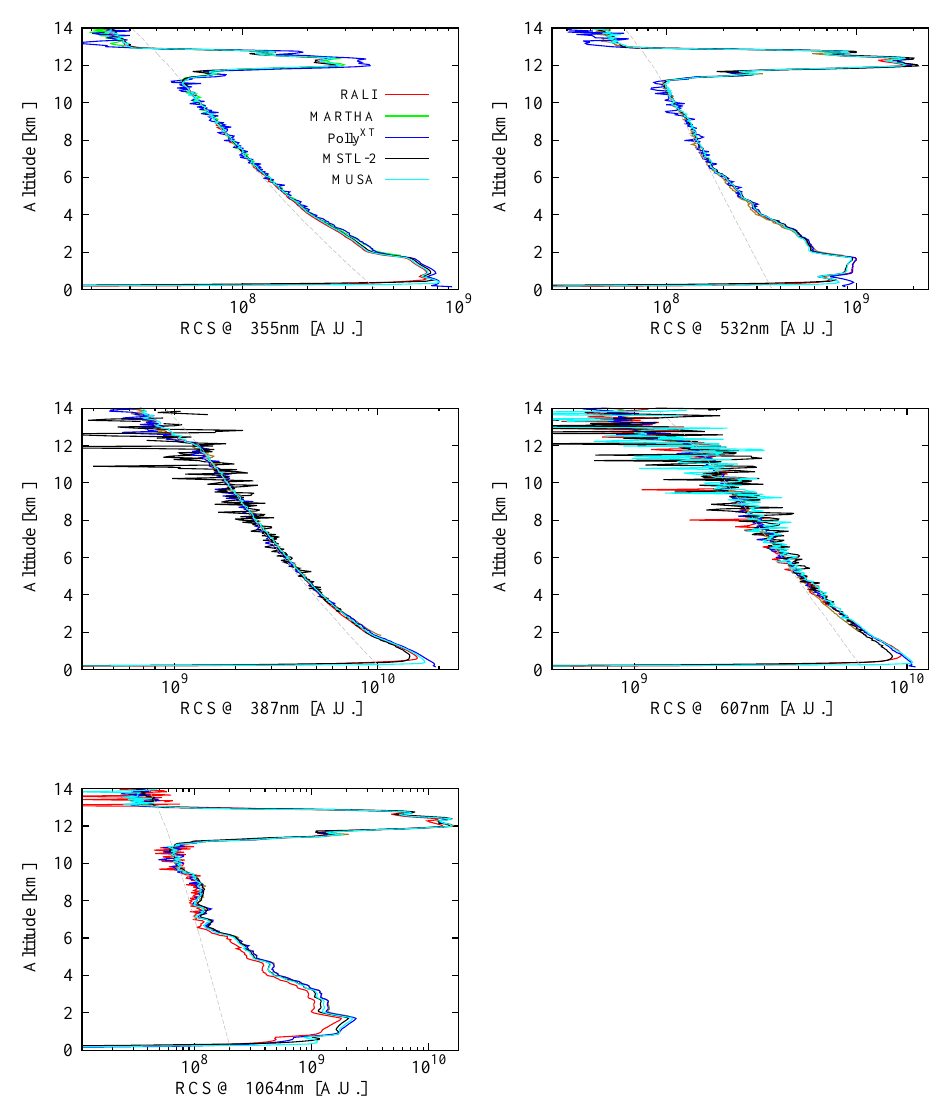
Figure 5. Range-corrected by ELPP for five lidar systems participating in the EARLI09 inter-comparison campaign (the same colour iden- tifies the same lidar system in all the plots). All profiles were taken from 21:00 to 23:00UT on 25 May 2009. From left to right, upper panel: elastic-backscattered signals at 355 and 532nm; middle panel: N 2 Raman backscattered signals at 387 and 607nm; bottom panel: elastic-backscattered signals at 1064nm. The dotted grey curves represent the signals backscattered by atmospheric molecules computed using a close radiosounding. All signals are normalized in the atmospheric region between 9.5 and 10.5km, which is assumed to be aerosol